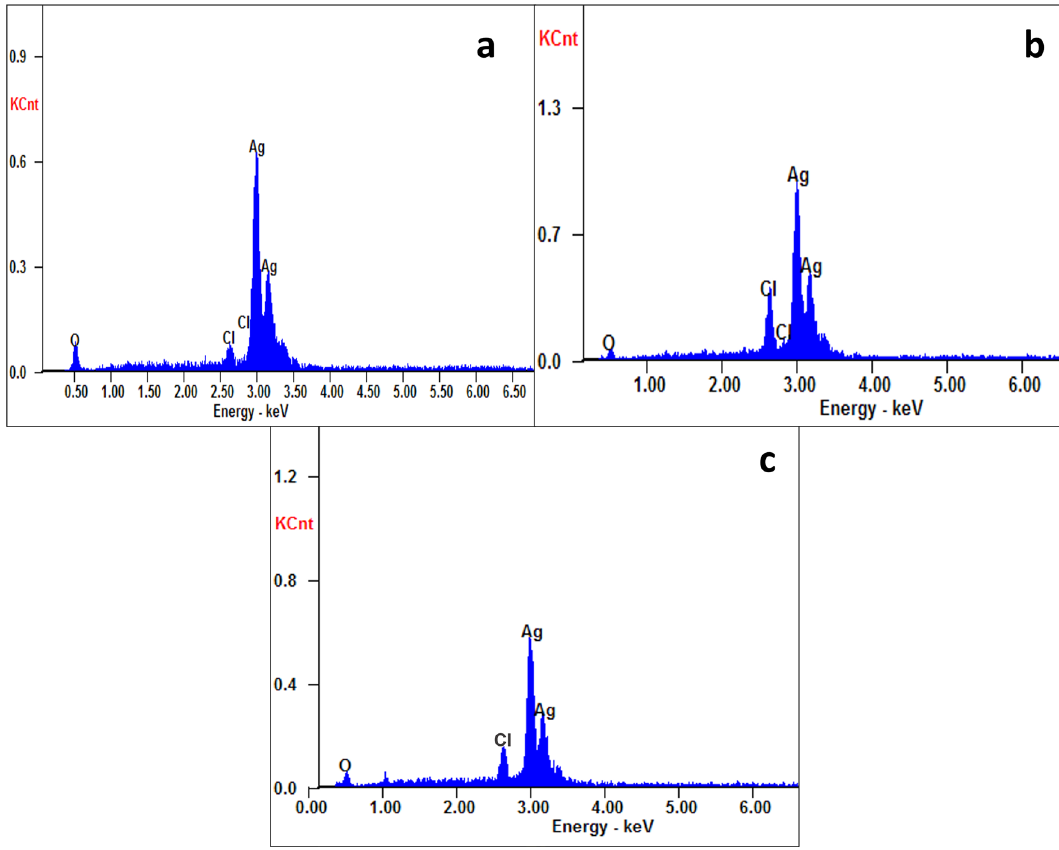
Figure 5. EDX spectra of ( a ) cinnamon AgNPs, ( b ) ginger AgNPs, and ( c ) chemical AgNPs.